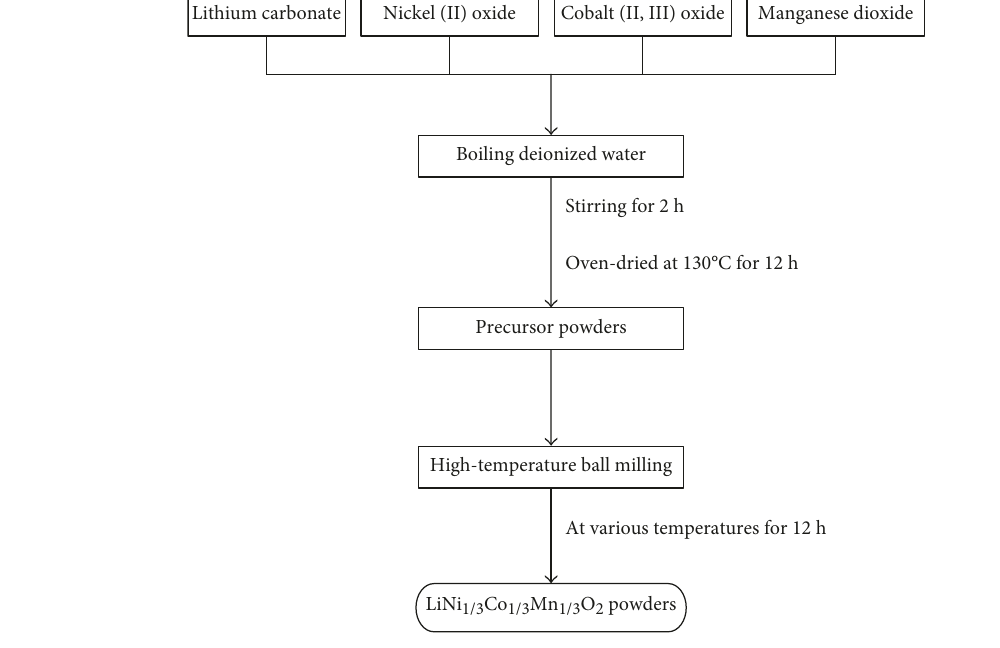
Figure 2: Flow sheet of the process route. Table 1: Lattice parameter of LiNi pared at various